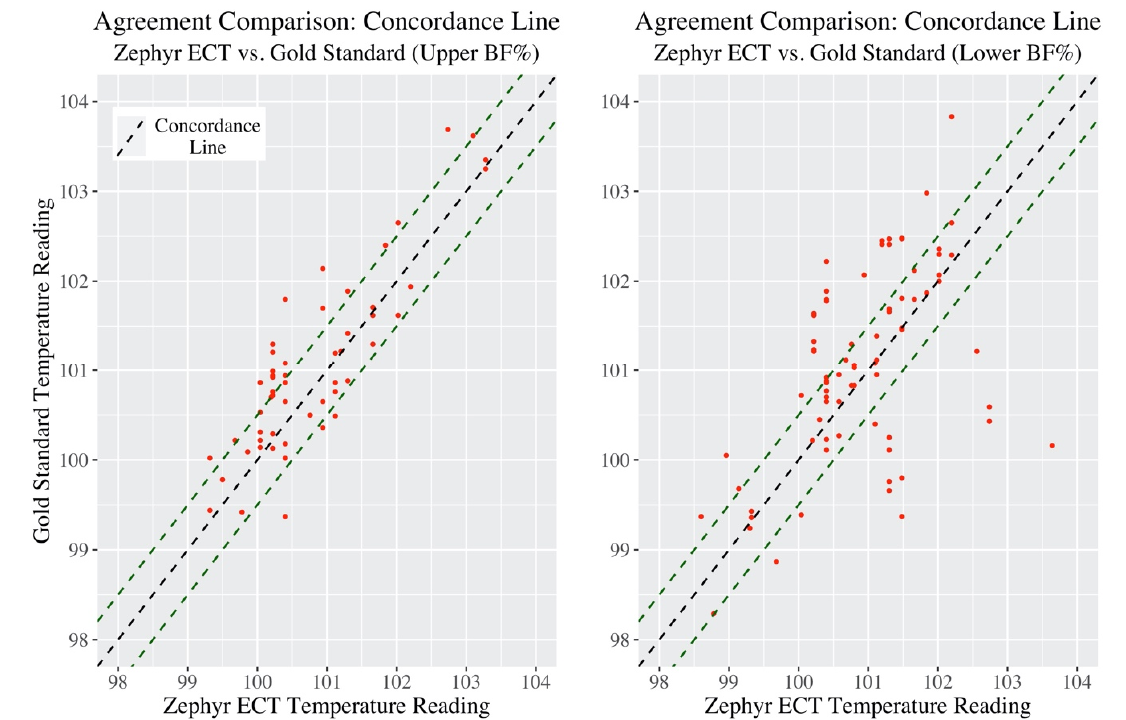
Figure 5. Concordance plots of Upper BF% group (left) and Lower BF% group (right).